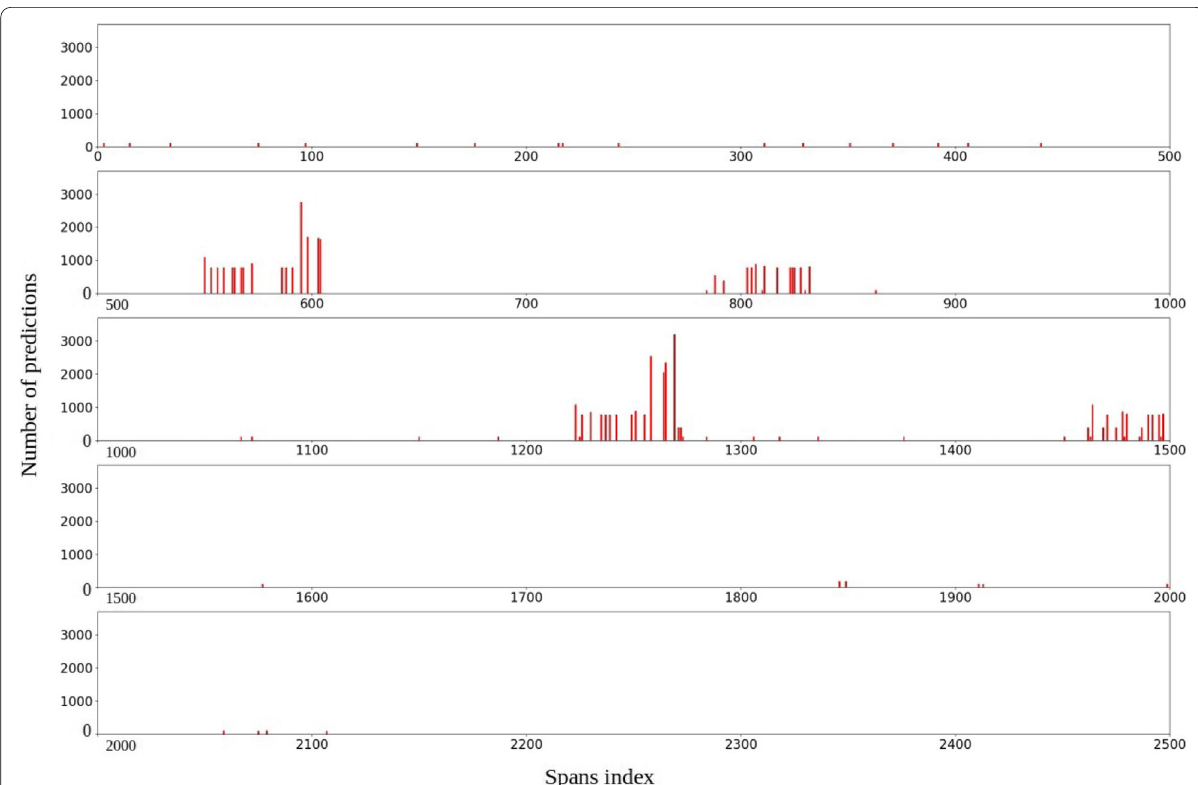
Fig. 9 The anomalous spans that appeared during the trace of the second scenario where each span has been drawn with a